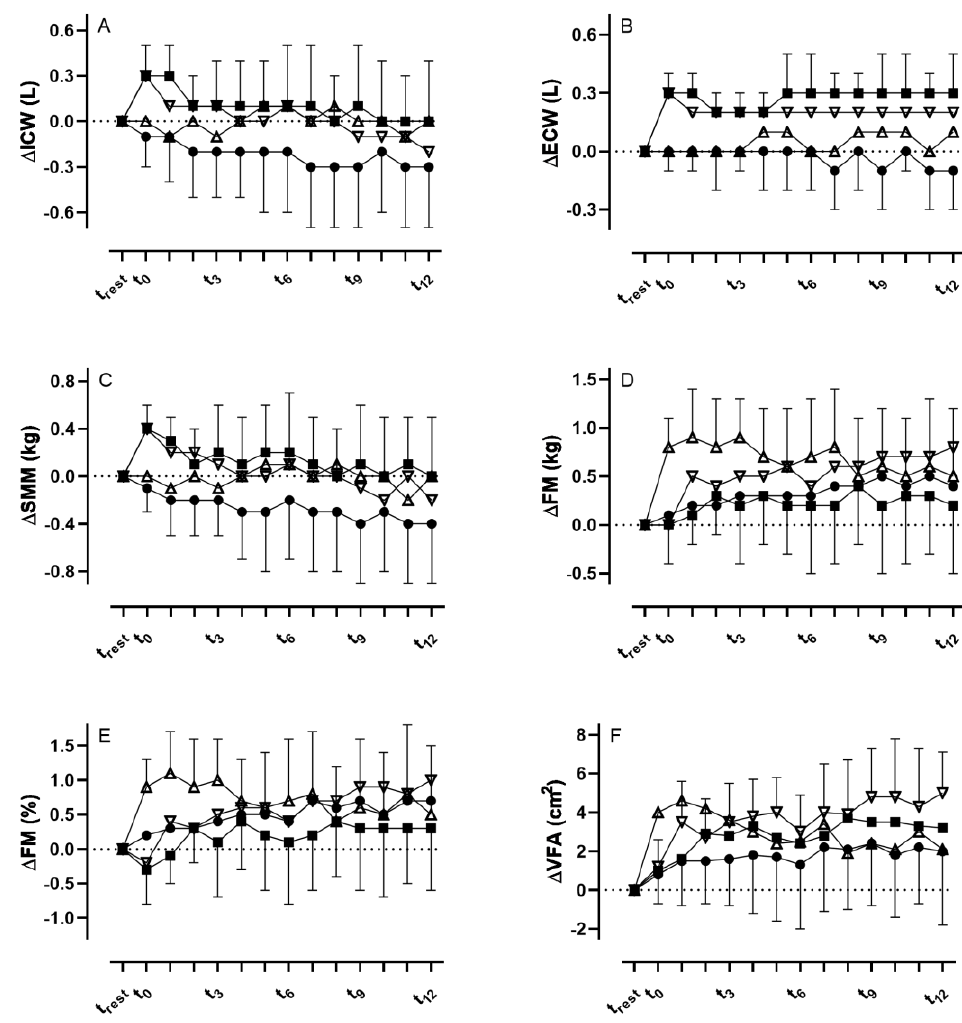
Figure 1. ( A , B ) Changes in intra- (ICW) and extracellular water (ECW), ( C ) skeletal muscle mass (SMM), ( D , E ), fat mass (FM), and ( F ) visceral fat area (VFA) after the consumption of the three different fluids and during the control visit (• = CON, Δ = GLU, ∇ = RIN, ■ = ISO). At t 0 , ICW was significantly increased in both the ISO and RIN trial arms when compared to CON and GLU ( p < 0.01); however, no changes were found between ISO and RIN ( p = 0.55). At t 10 , ISO was significantly increased when compared to CON ( p < 0.05) but not to RIN (<0.99) or GLU ( p = 0.11).